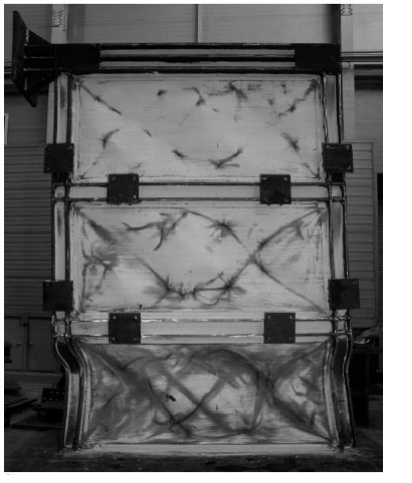
Figure 3. Experimental and finite element model after loading. ( a ) Experimental model [33]. ( b ) Fi- nite element model.